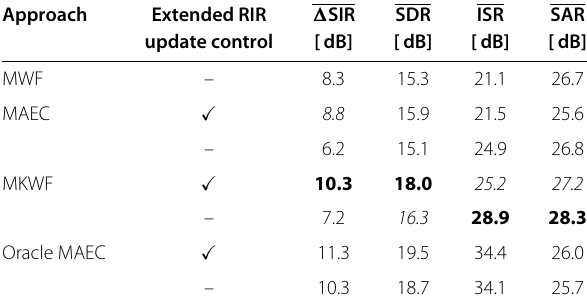
Table 2 Performance evaluation of the extended RIR update control strategy w.r.t. the MAEC, MKWF, and oracle MAEC approach. MWF results are provided for better comparison. All results are averaged over all iSIR conditions in the considered meeting scenario. First and second ranked results are bold face and italicized, respectively (oracle results excluded) Approach Extended